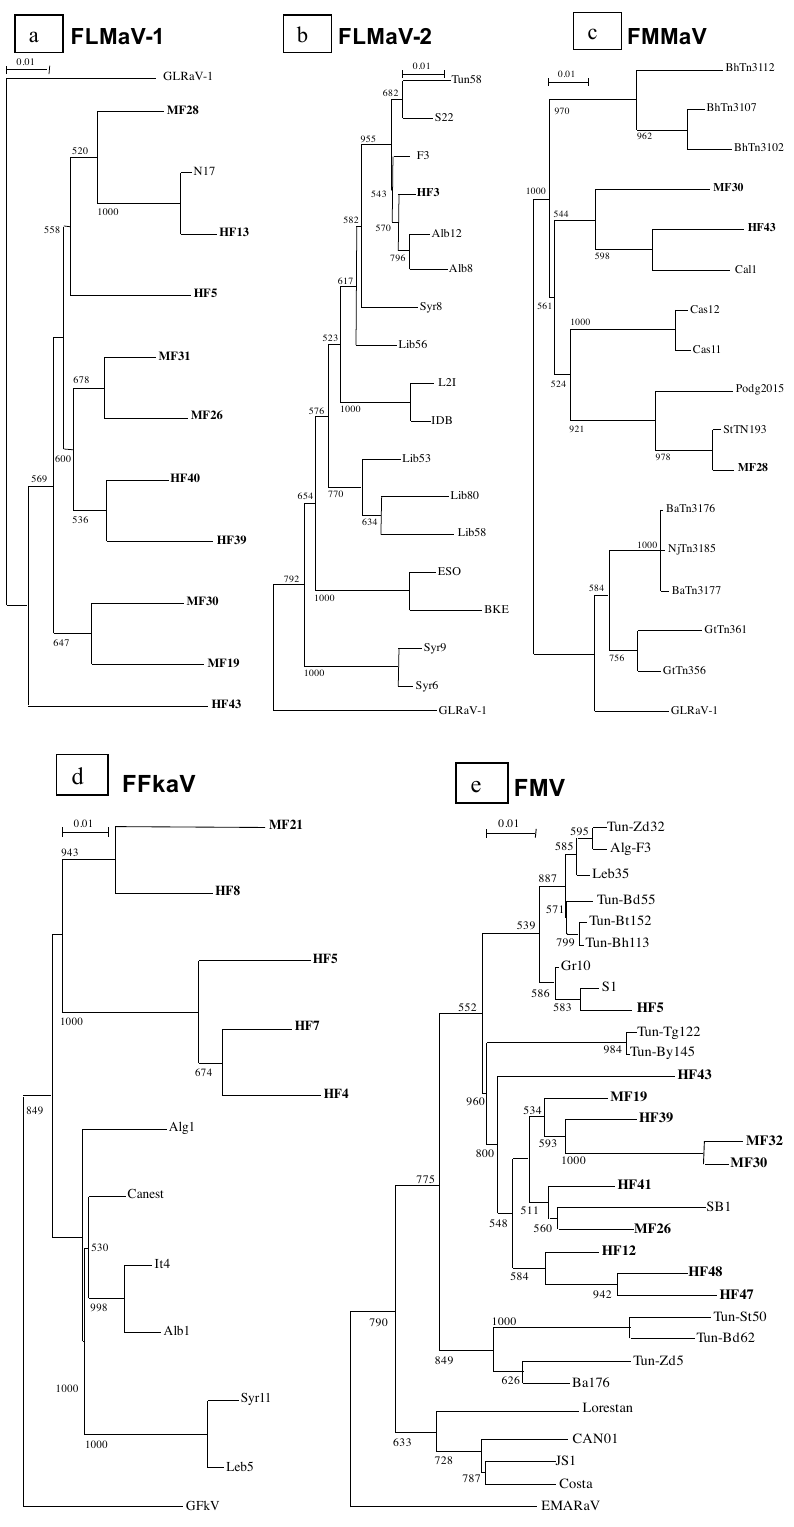
Figure 1 . Phylogenetic trees gener- ated from the alignment of nucleo- tide sequences for partial genes of: a) Fig leaf mottle-associated virus 1 (FLMaV-1), b) Fig leaf mottle-associ- ated virus 2 (FLMaV-2), c) Fig mild mottle-associated virus (FMMaV), d) Fig fleck-associated virus (FFkaV), e) Fig mosaic emaravirus (FMV) and BiH, MNE isolates, together with homo - logue sequences reported in the Gen- bank (Supplementary Table 2), using the neighbour-joining algorithm, p-distance method and bootstrap consisting of 1,000